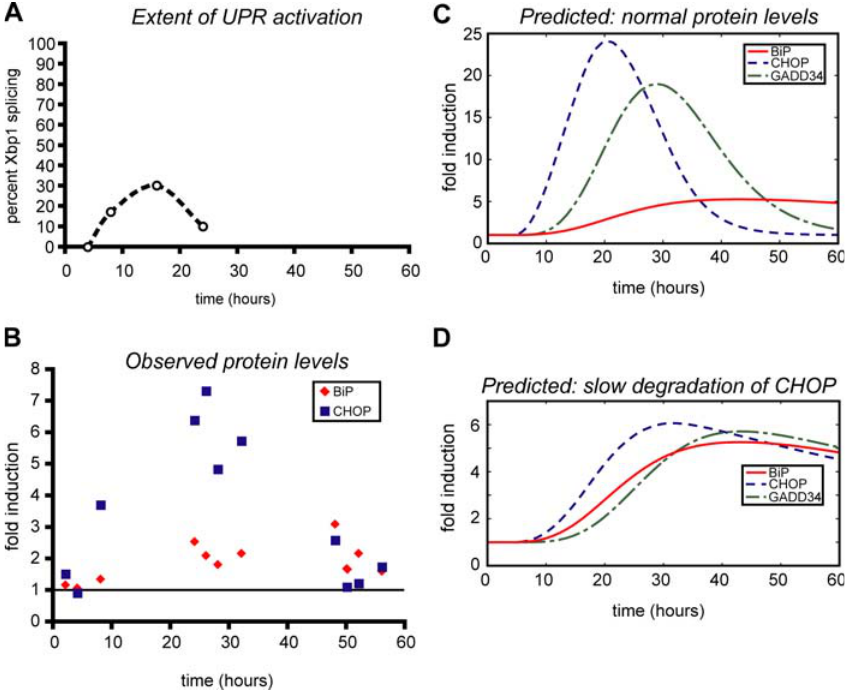
Figure 7. Rapid Degradation of CHOP and GADD34 mRNAs and Proteins Allows Their Expression to Be Down-Regulated as Cells Adapt (A) Xbp1 mRNA splicing during a 24-h time course of TM treatment (25 ng/ml) was quantitated and used to approximate the stress level in cells at given times (taken from Figure 2B and unpublished data). These data were used as the basis for the stress input in a mathematical model describing the production of BiP, CHOP, and GADD34 mRNAs and proteins. The dashed line is used only to provide a visual aid for the trend of splicing over the time course. (B) The relative expression of CHOP and BiP protein was quantitated by immunoblot from cells exposed to 25-ng/ml TM over a 48-h time course (the media and stressor were refreshed at 24 h), normalized against untreated cells (data taken from an experiment, not shown, similar to Figure 3A and 3C). (C) and (D) A mathematical model used experimental data (such as that obtained from Figures 3 and 5) to derive production and degradation rates for ATF4, CHOP, and GADD34, and ATF6 and BiP, and was used to test the effect of altering the stabilities of components within the ATF4-CHOP-GADD34 axis on the responsiveness of these components to the stress level. ‘‘ C ’’ shows the model-predicted expression of these proteins using their experimentally derived degradation rates, while ‘‘ D ’’ illustrates the changes in CHOP and GADD34 protein levels brought about by making the degradation rate of CHOP protein comparable to that of BiP protein. Note the change in y-axis scale between panels ‘‘ C ’’ and ‘‘ D ’’ ; expression of BiP does not change between these panels. See text and Protocol S1 for further details. DOI: